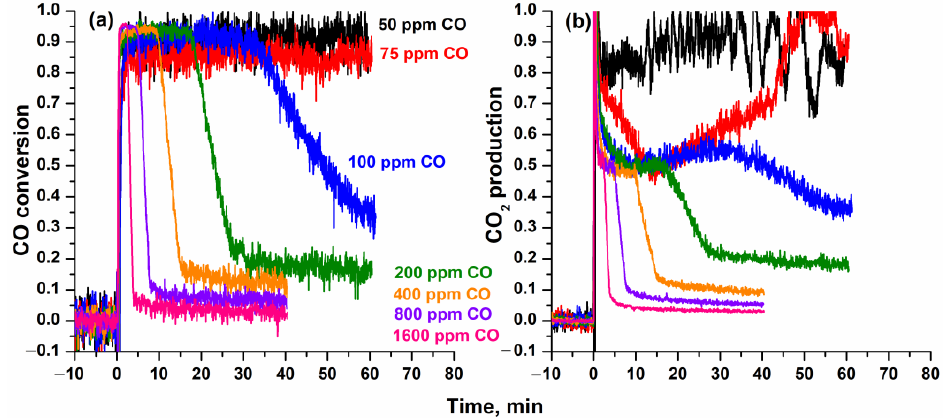
Figure 4. ( a ) CO conversion and ( b ) CO 2 production versus time at 25 °C. The reaction mixture contains 50, 75, 100, 200, 400, 800, and 1600 ppm CO, 5 vol.% O 2 , 0.5 vol.% Ne, and He balance. The reaction mixture rate was 100 cm 3 /min. SV = 60 L/g·h.